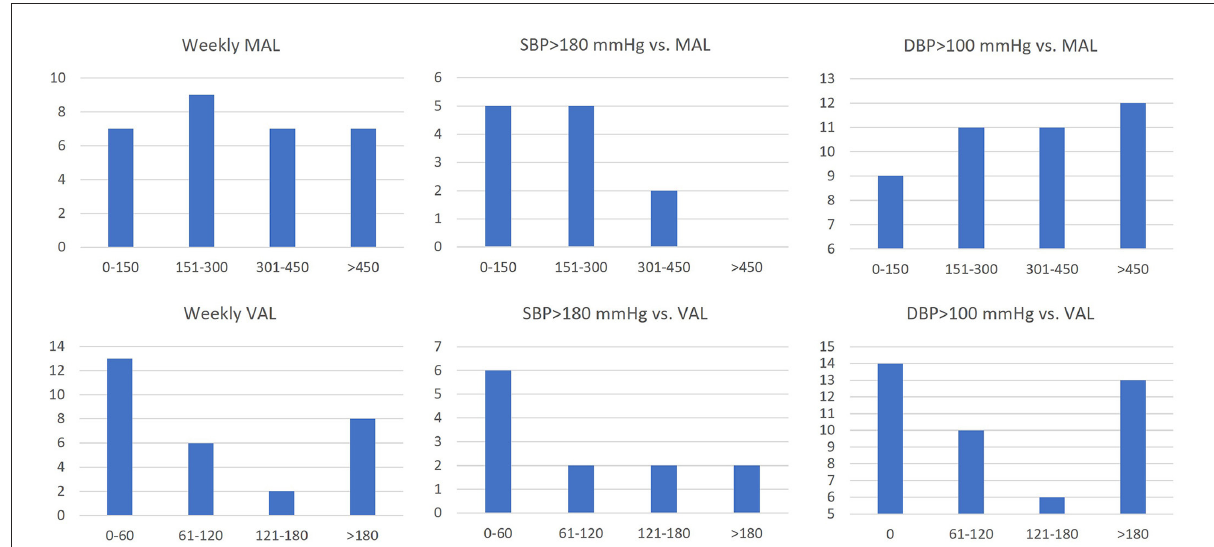
FIGURE2 Number of exertional SBP measurements > 180 mmHg ( n = 12) or exertional DBP measurements > 100 mmHg ( n = 43) correlated with weekly moderate activity level (MAL) and vigorous activity level (VAL) in TAD patients. Y-axis: number of patients or exercise measurements; x-axis: weekly activity level (min/week).